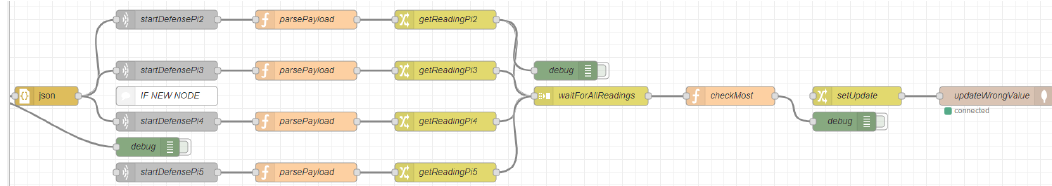
Figure 7. Second part of the defence flow: requesting data and make a